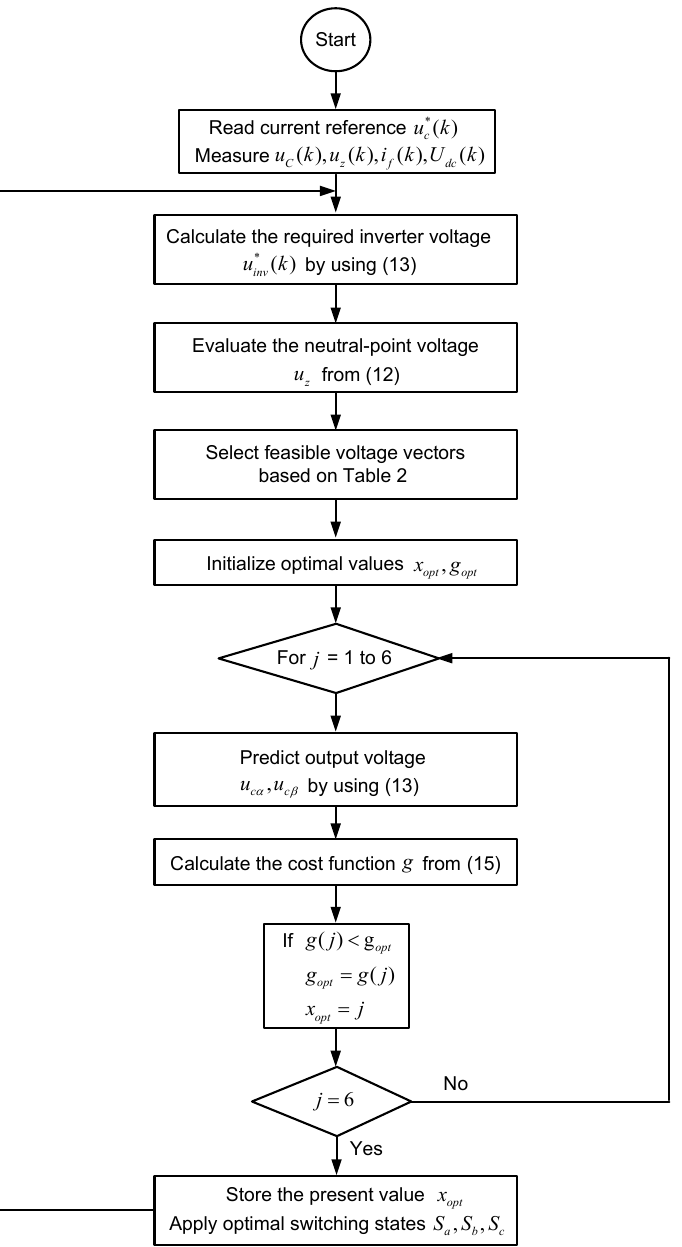
Figure 4. Flowchart of the proposed control